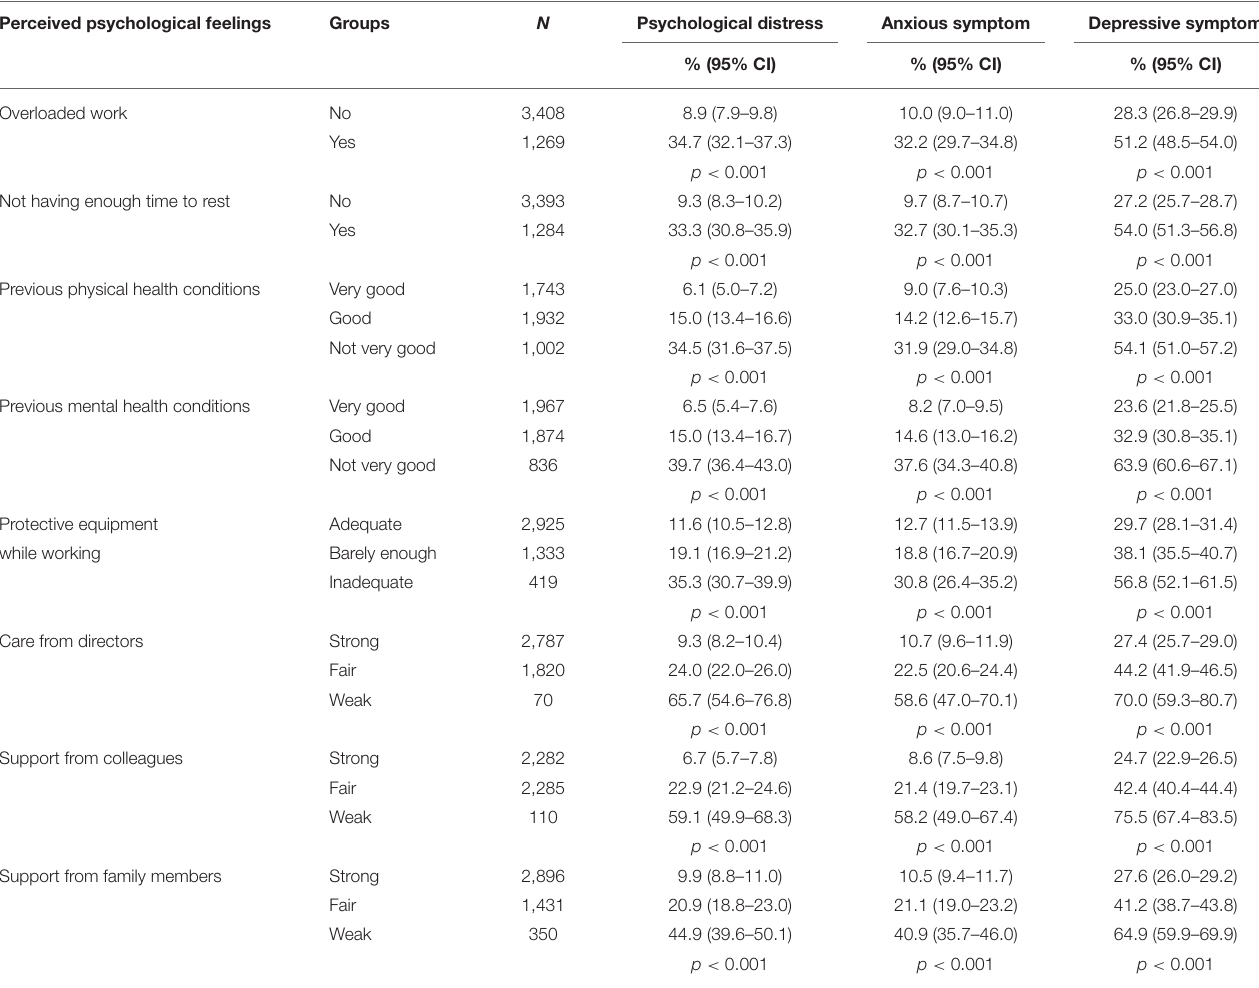
% (95% CI) % (95% CI) % (95% CI)